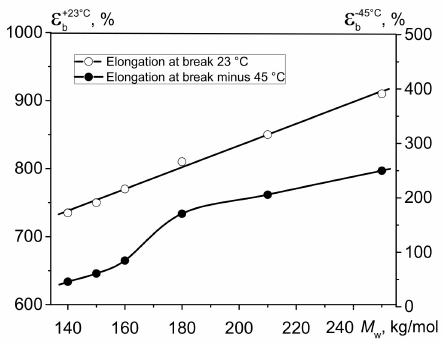
Figure 2. Relative elongation at break at test temperatures of +23 ◦ C ( E b+23 ) and − 45 ◦ C ( E b − 45 ) as a function of M w for the bimodal HDPE